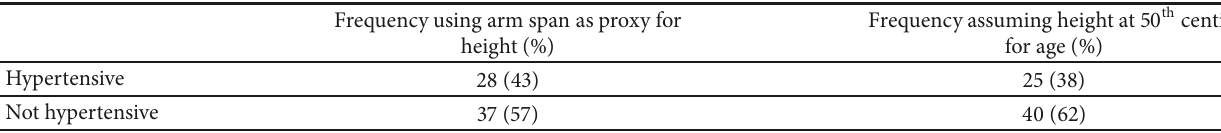
Table 2: Frequency of hypertension. Hypertension was defined as lowest systolic and/or diastolic blood pressure at or above the 95th centile based on age and